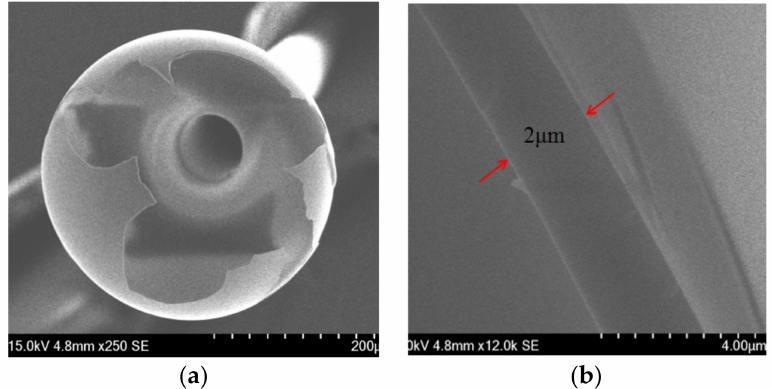
Figure 4. Result of SEM experiment. ( a ) Collapsed single-ended microbubble; ( b ) measured wall